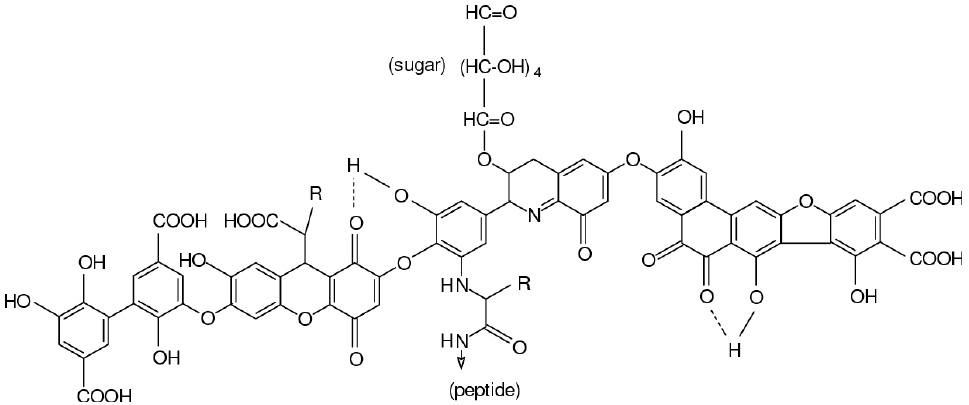
Figure 2. Model structure of humic acid according to Stevenson [34].